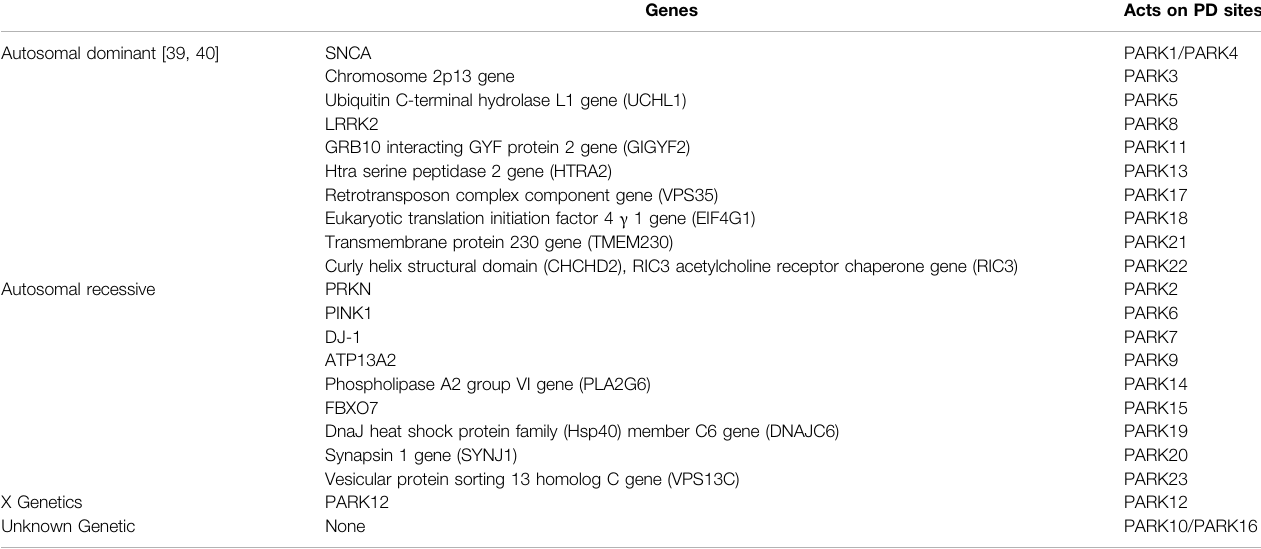
TABLE 1 | Common autosomal genes and PD